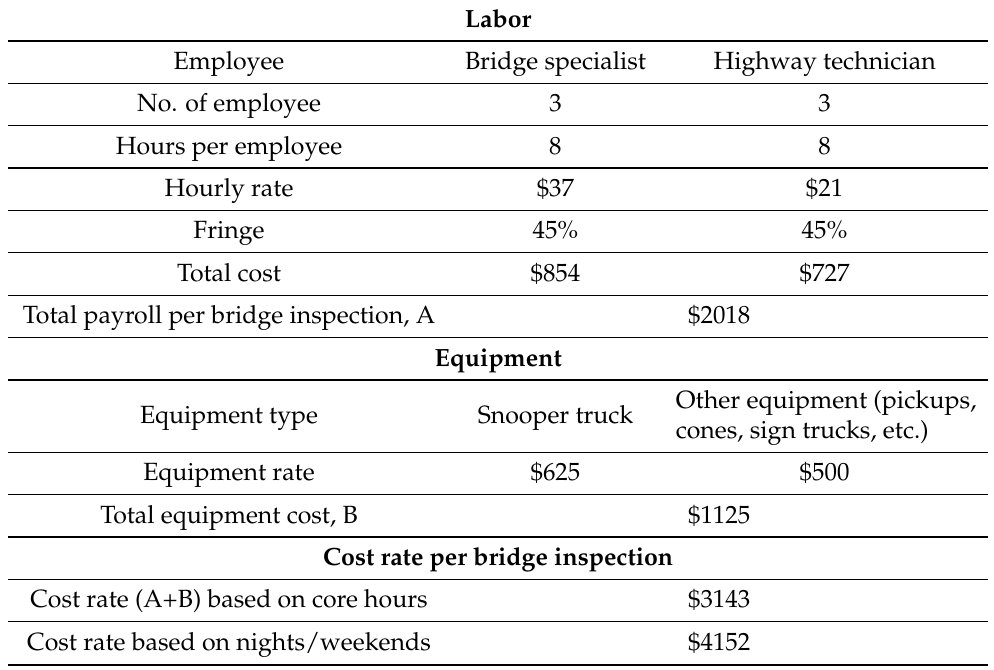
Table A1. Operational cost rate per bridge inspection using snooper (source: [68]).